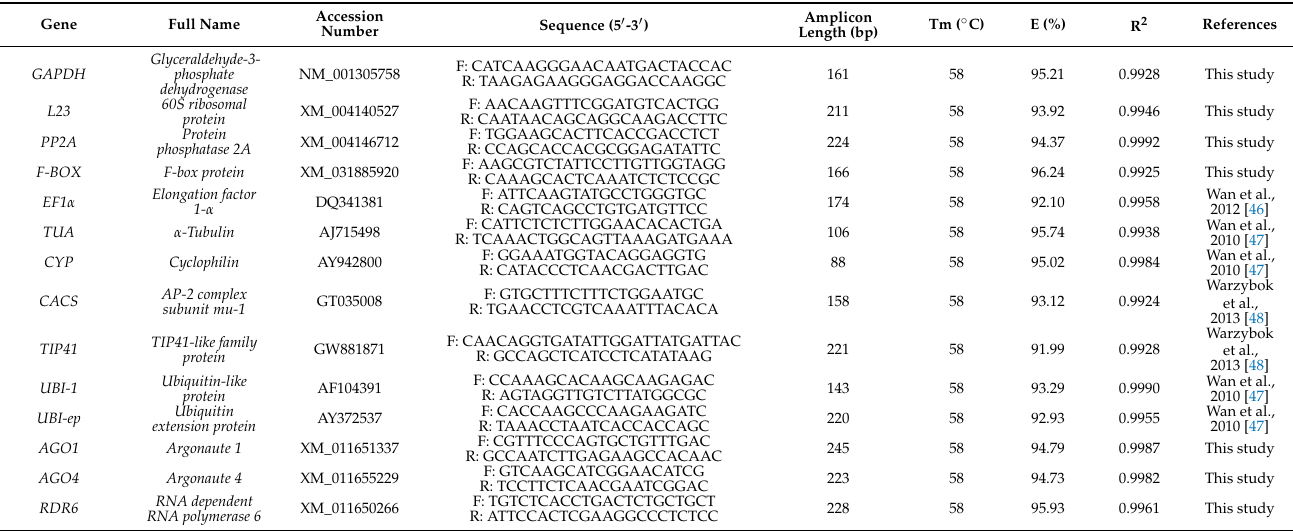
Table 1. Primers used in this study. Tm, annealing temperature; E: PCR amplification efficiency; R 2 : correlation